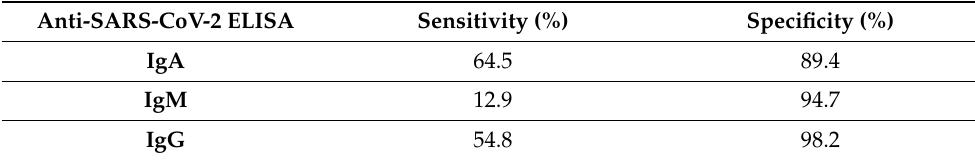
Table 3. Sensitivity and specificity of anti-SARS-CoV-2